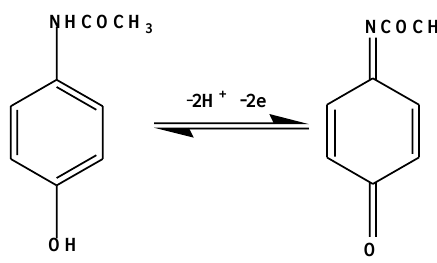
Figure 1. Oxidation of acetaminophen in an acidic environment .